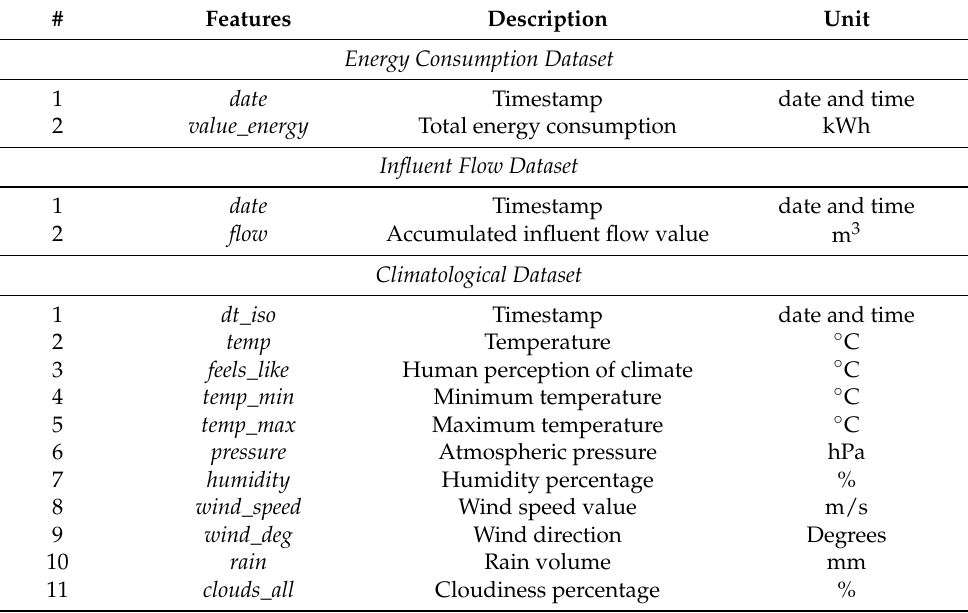
Table 1. Features available in the used datasets. Only the main features of the climatological dataset are presented.